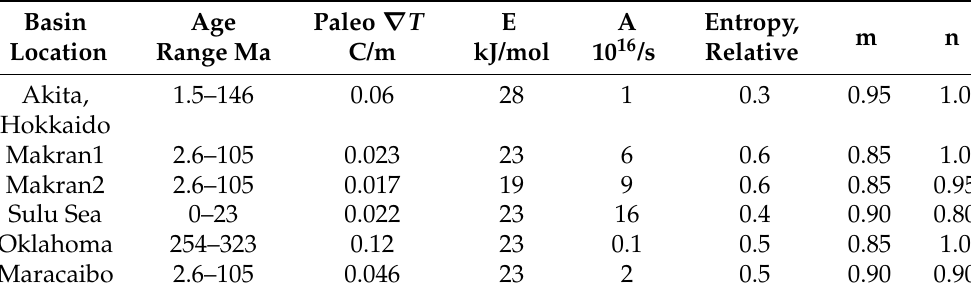
Table 3. Inferred parameters for E av = 23 ± 6